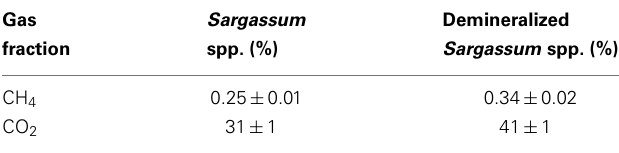
Table 4 | GC-TCD analysis of the HTL gas fraction obtained for untreated and demineralized Sargassum biomass